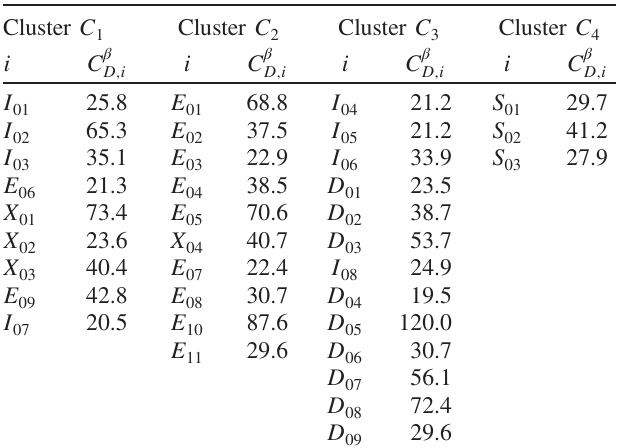
TABLE I. Weighted degree, C β D;i , of each survey item, i , grouped by clusters. Here, β ¼ 0 . 5